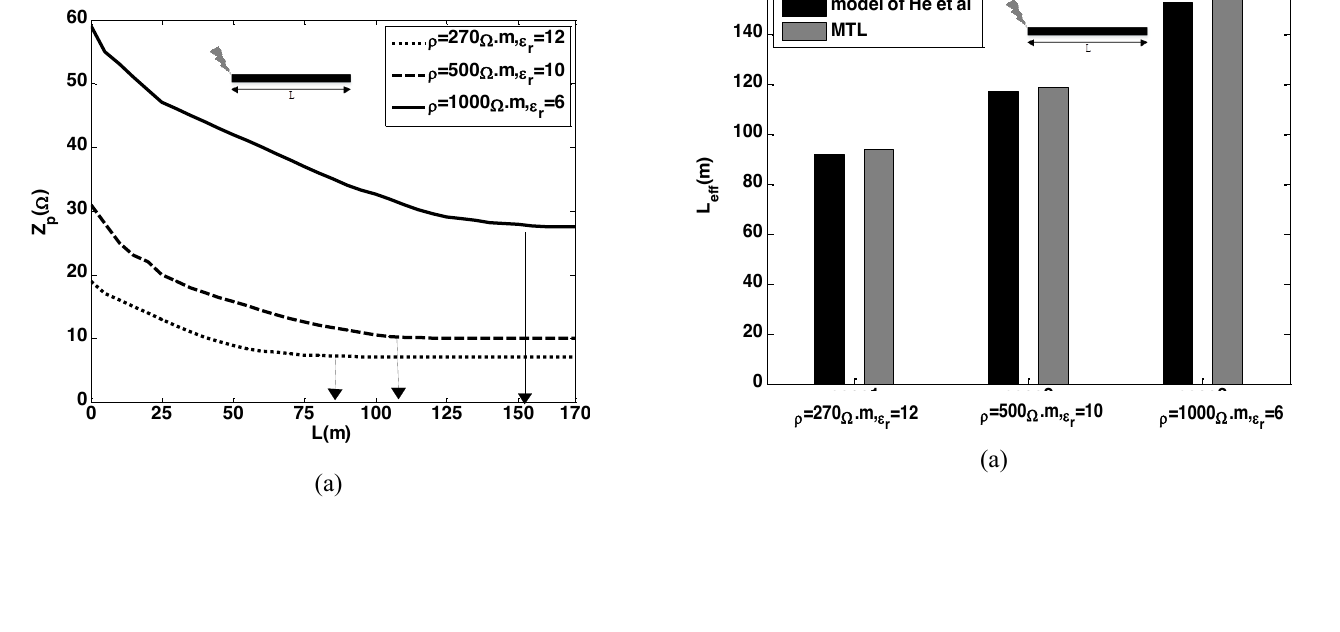
Figure 7: Transient voltage of (a): corner-fed electrode, (b): center-fed electrode with two arms, and (c): center-fed electrode with four arms for the three lossy soils with and without considering ionization of soil.